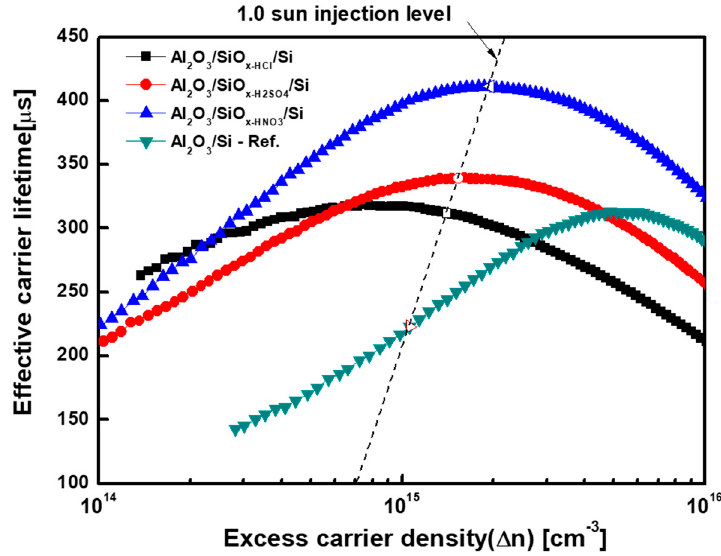
Figure 4. Effective carrier lifetime curves as a function of the excess carrier density ( Δ n) for Al 2 O 3 /SiO x-acidic /Si structures and Al 2 O 3 /Si reference sample. The Al 2 O 3 thickness is 10 nm and the SiO x thicknesses are 1.49 nm for SiO x-HCl , 1.32 nm for SiO x-H2SO4 , and 1.50 nm for SiO x-HNO3 , respectively.